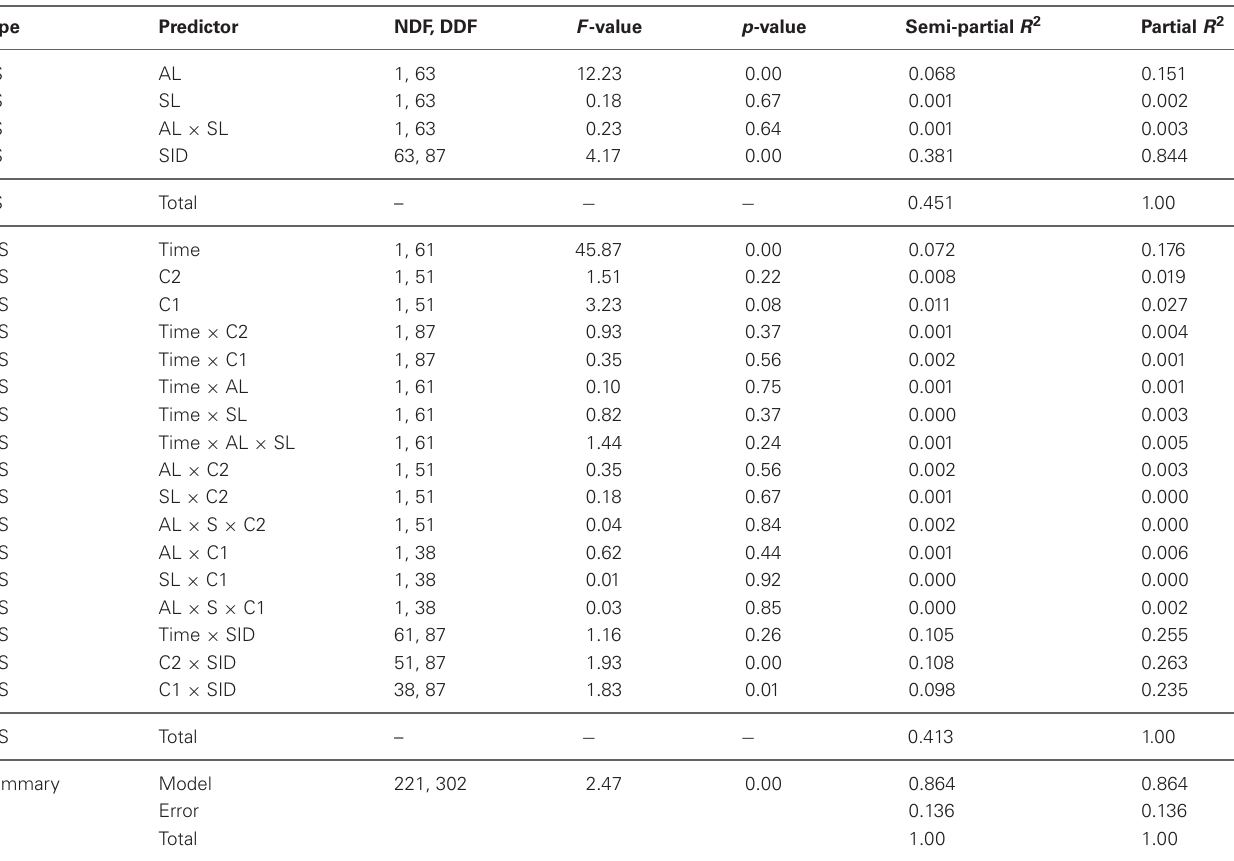
Table 8 | Hypothesis tests and effect sizes for between-subjects and within-subjects